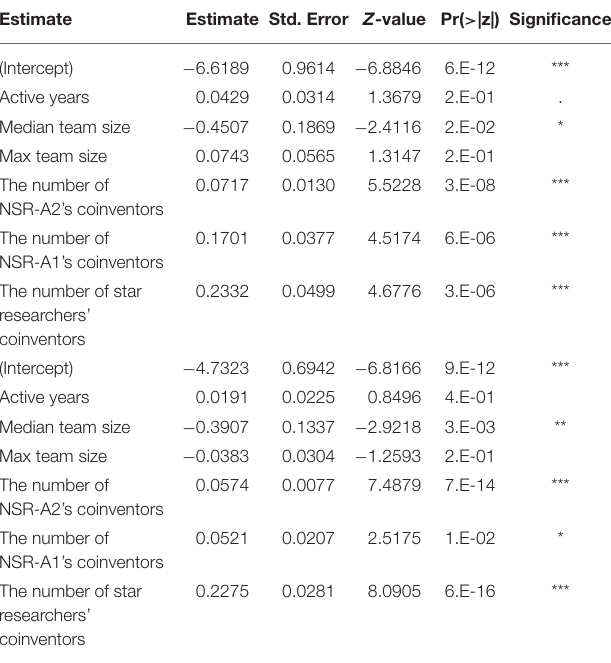
TABLE 2 | Dependent variables of a binomial logistic regression explaining star researchers vs. NSR-A2 (above), and star researchers vs. all other researchers (below).